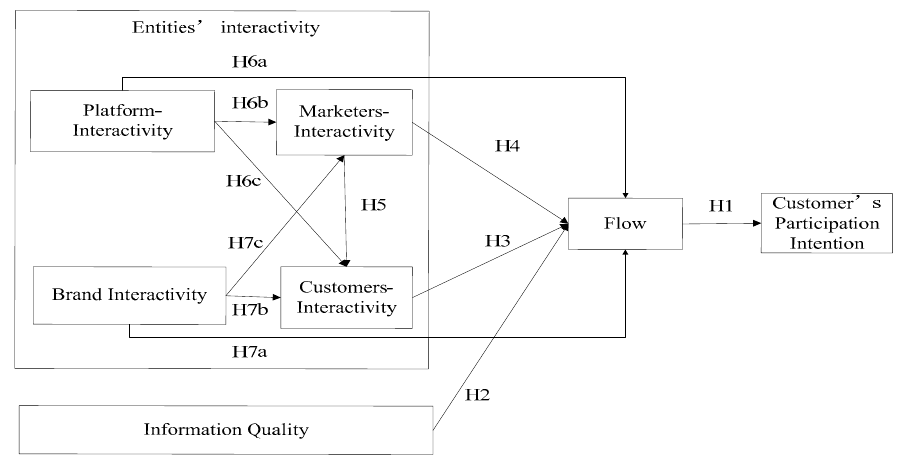
Figure 1. Research model.